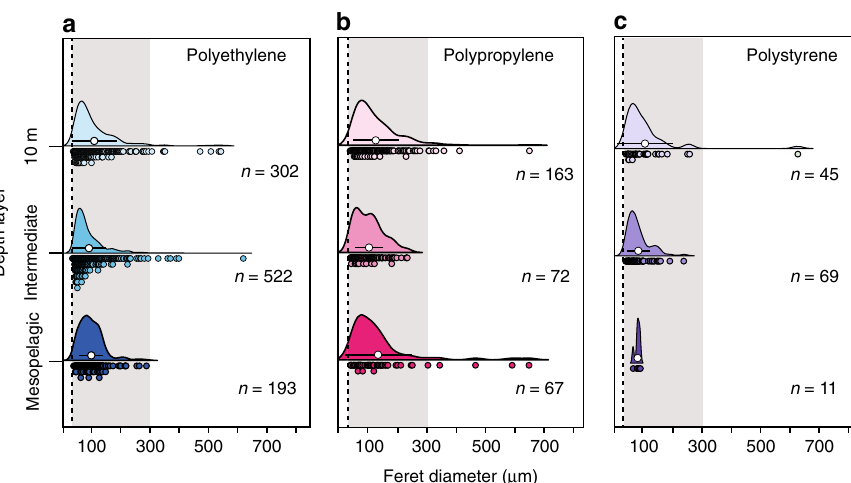
Fig. 3 Size distribution of microplastics with depth. a Polyethylene, b polypropylene and c polystyrene. Data points making up the distributions are shown as circles of the respective colour. The width of each distribution was scaled to be equal to allow the inter-comparison of the distributions regardless of the number of data points ( n ). The white circles indicate mean particle sizes with horizontal bars as ±standard deviation. Dashed line marks the lowest particle size measured (32 µ m) in this study. The dominance of microplastics <300 µ m in size is highlighted in grey. Source data set is provided in ref. 24 .